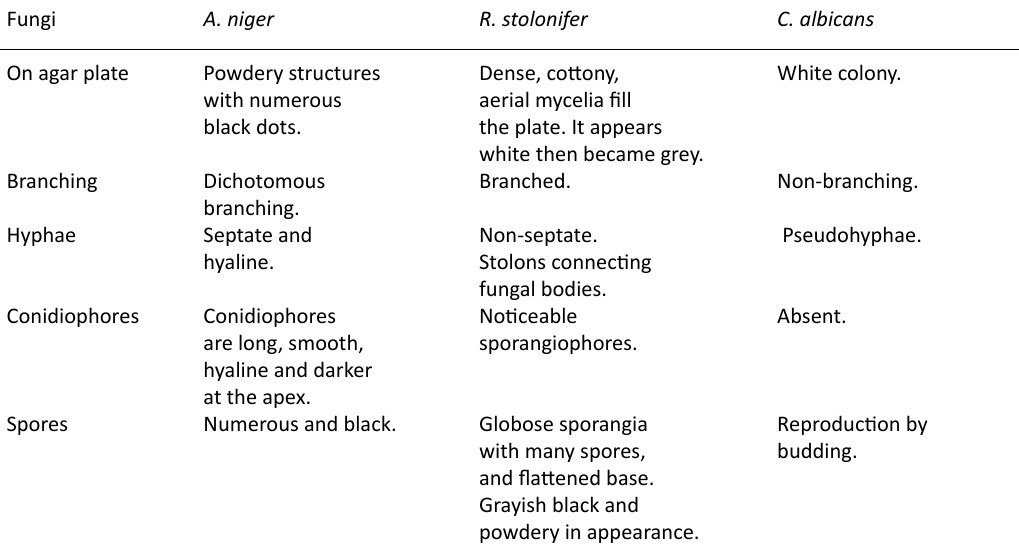
table 8. Macroscopic and microscopic characterization of the isolated fungi Fungi